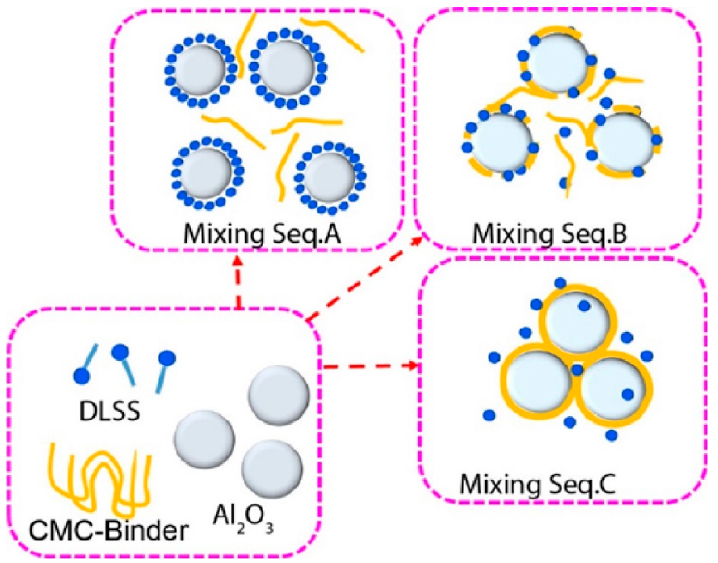
Figure 4. Schematics illustrate the interactions between ceramic Al 2 O 3 particles, CMC polymer binder molecules, and DLSS surfactant according to the three mixing sequences.